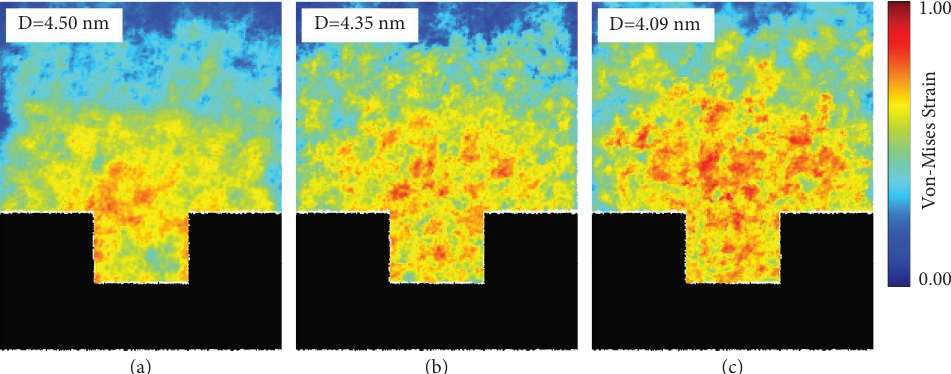
Figure 7: Imprinting process with groove pattern in the complete flling stage at (a) 300K, (b) 500 K, and (c)